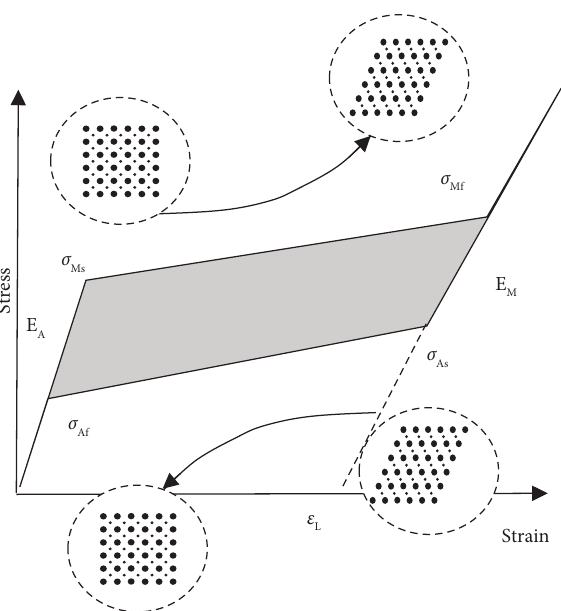
Figure 1: Stress-strain diagram of a typical superelastic SMA